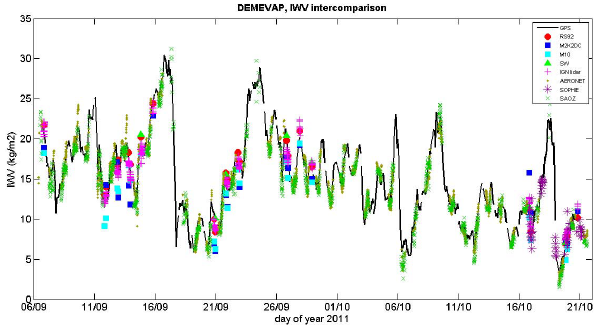
Fig. 15. Time series of IWV from the instruments that participated in the DEMEVAP 2011 campaign (see